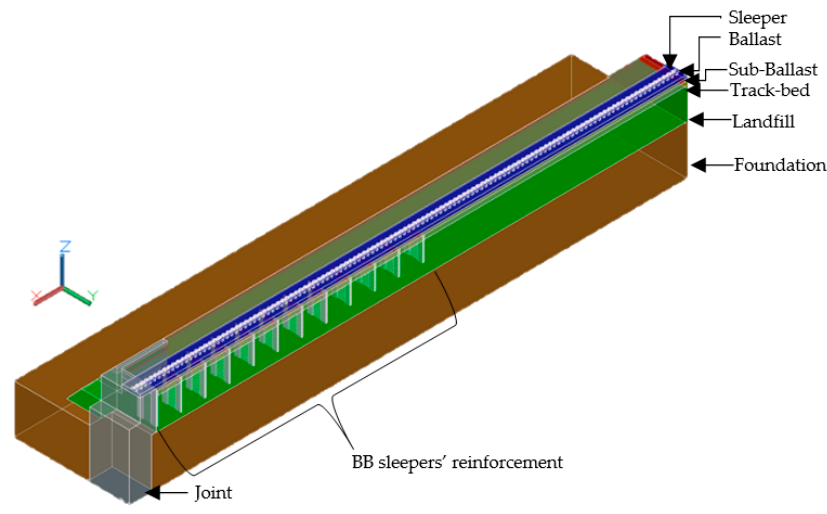
Figure 4. Horizontal BB sleeper reinforcement arrangement